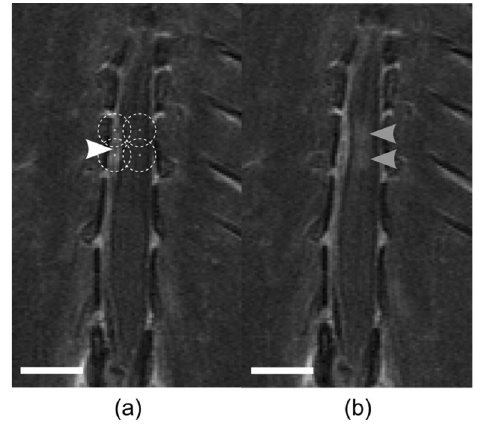
Figure 3. Example gadolinium enhanced T1w coronal MR images pre- and post-FUS for drug delivery to a rat model of LM. ( a ) Pre-FUS treatment planning MR image. Points are spaced at a 2 mm pitch. The leftmost points fall within the tumor boundary (white arrowhead) and the rightmost points fall adjacent to serve as a positive control for BSCB opening. Dashed circles represent the lateral beam width in water at the fundamental frequency (580 kHz). ( b ) Post-FUS MR image showing enhancement within the spinal cord following BSCB opening (grey arrowheads). All scale bars = 5